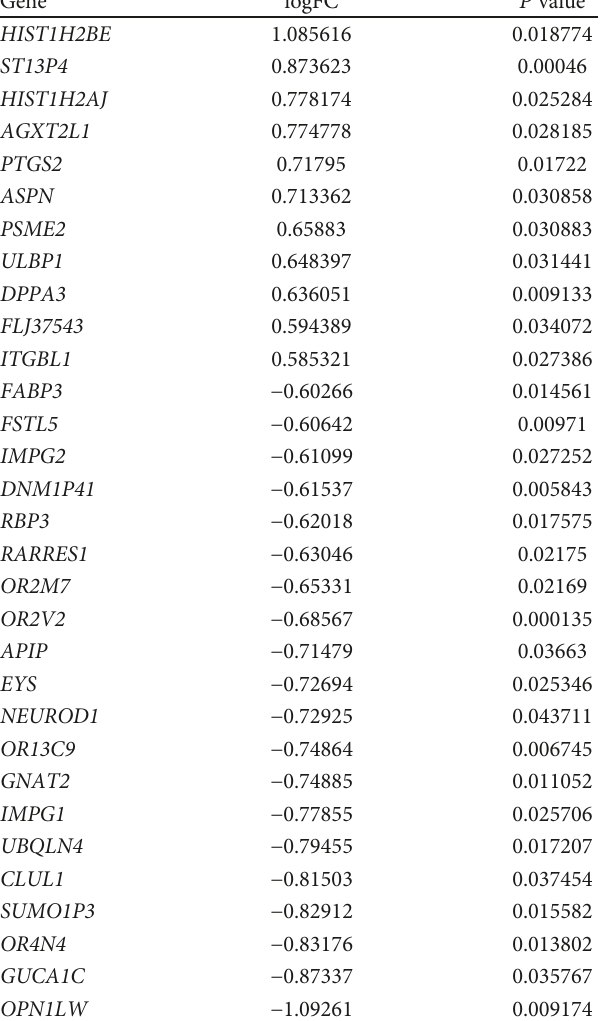
Table 1: The 31 signi fi cant DEGs between POAG ONH and normal ONH